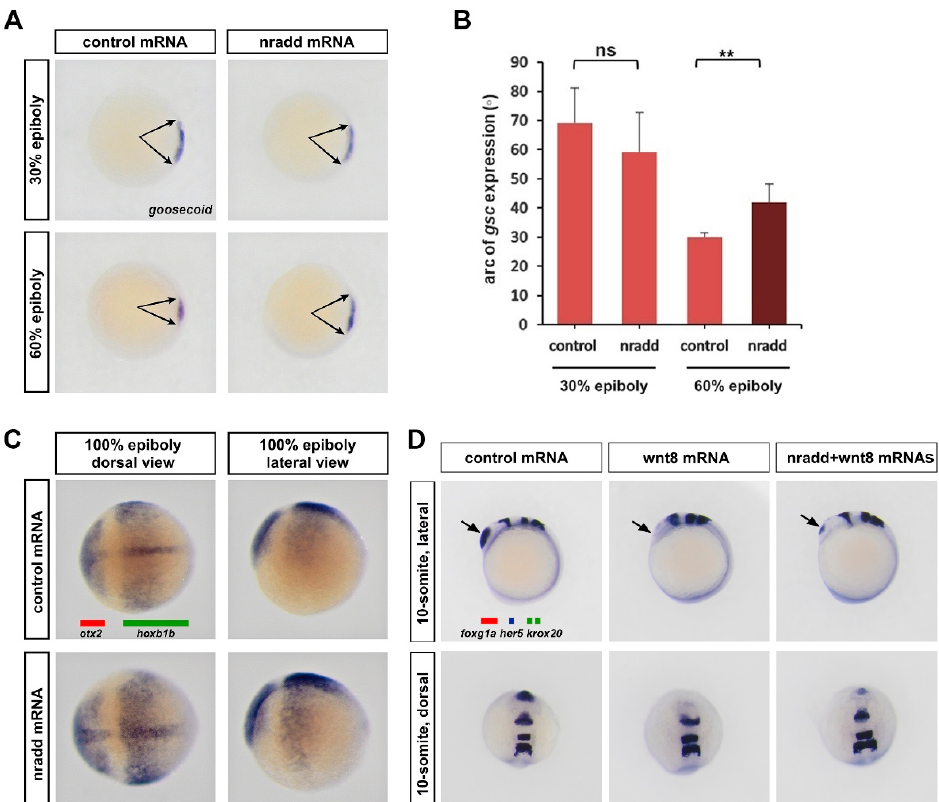
Figure 3. nradd suppresses Wnt-mediated patterning of the mesoderm and the neuroectoderm. ( A ) nradd mRNA (250 pg) causes expansion of the dorsal organizer domain (arrows) marked by goosecoid (gsc) WMISH, not at late blastula (30% epiboly, n: control 23/23 embryos, nradd 26/29 embryos), but at early gastrula (60% epiboly, n: control 27/27 embryos, nradd 32/33 embryos) stage zebrafish embryos. Three independent experiments were conducted. ( B ) Quantification of gsc expression shown in (A) by measurement of arc degree (29 embryos in control 30% epiboly, 33 embryos in nradd 30% epiboly, 35 embryos in control 60% epiboly, 37 embryos in nradd 60% epiboly). Error bars are SD. ** indicates p < 0.01 and ns is non-significant. ( C ) nradd mRNA (250 pg) results in expansion of the anterior neuroectodermal marker otx2 (red bar) and a complementary reduction of the posterior neuroectodermal marker hoxb1b (green bar) defined by WMISH at the 100% epiboly stage (n: control 35/35 embryos, nradd 38/41 embryos). Three independent experiments were conducted. ( D ) nradd mRNA (250 pg) restores the telencephalon, marked by foxg1a (arrowhead), that is completely abolished by wnt8 mRNA (20 pg). WMISH is performed to detect expression of three independent RNAs, the forebrain marker foxg1a (red bar), the midbrain–hindbrain boundary marker her5 (blue bar) and the rhombomere 3/5 marker krox20 (two green bars) in zebrafish embryos at the 10-somite stage (n: control 33/33 embryos, wnt8 35/36 embryos, nradd+wnt8 42/45 embryos). Three independent experiments were conducted.